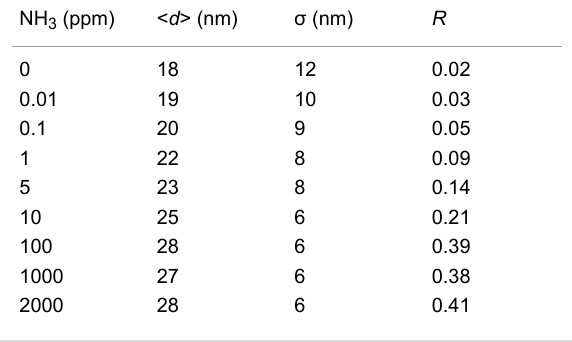
Table 1: Nanoparticle mean diameter < d > and relative standard devia- tions σ together with the coverage index R . NH 3